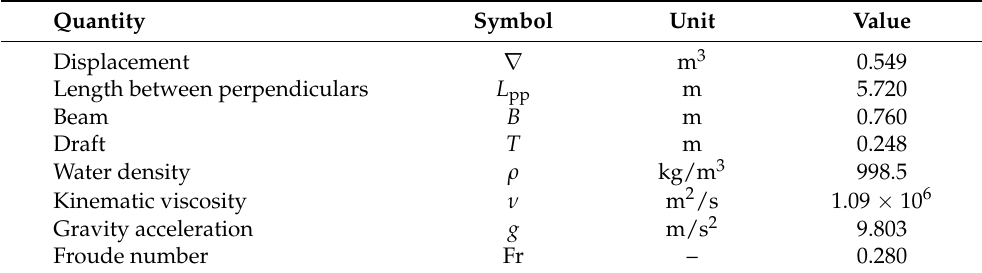
Table 1. DTMB 5415 original hull main particulars and simulation